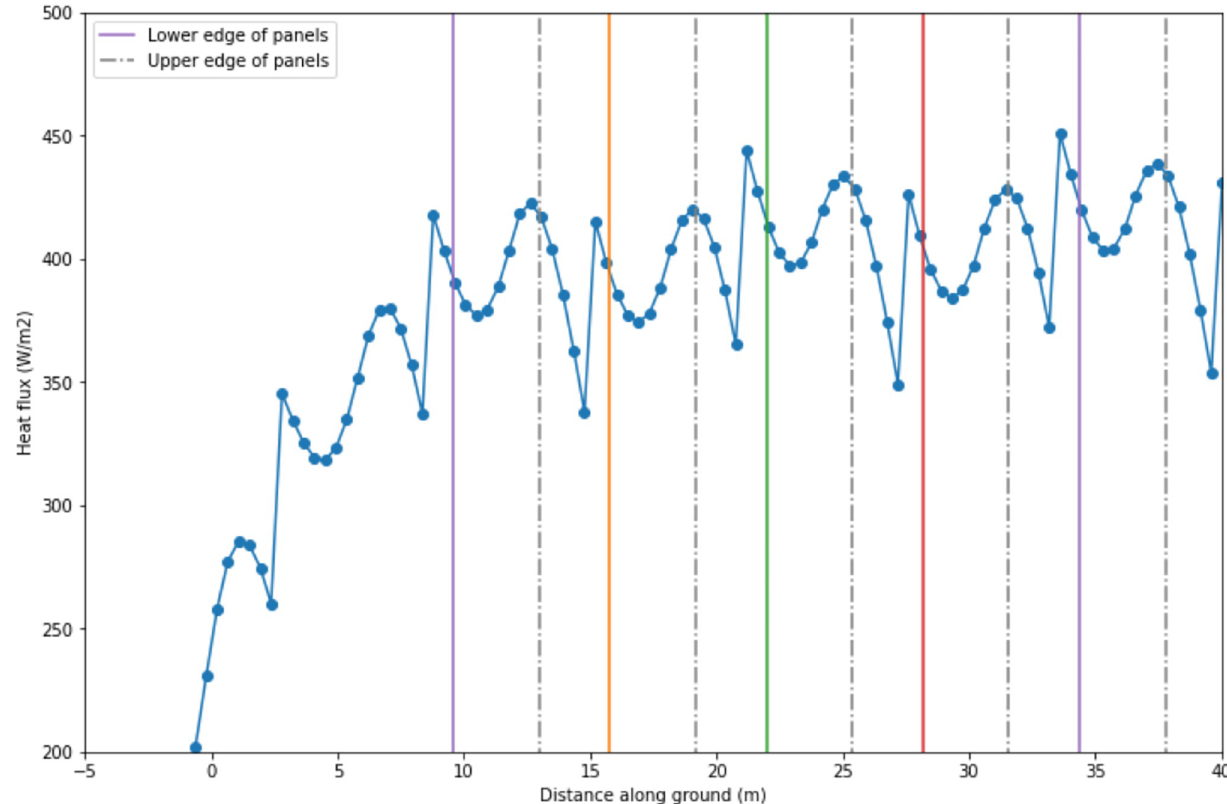
Fig 4. Heat flux as a result of solar panels only (no sky), for arbitrary panel temp T P = 300 K, where x = 0 occurs at lower edge of leftmost panel.